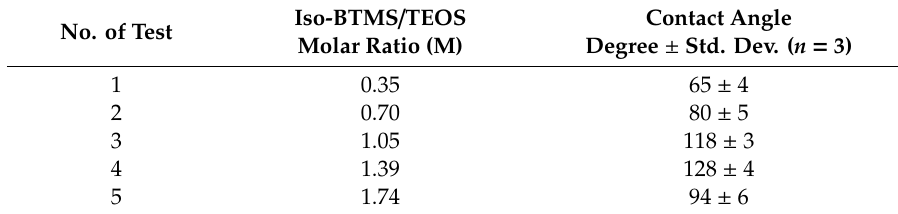
Note: Reaction time = 4 h.